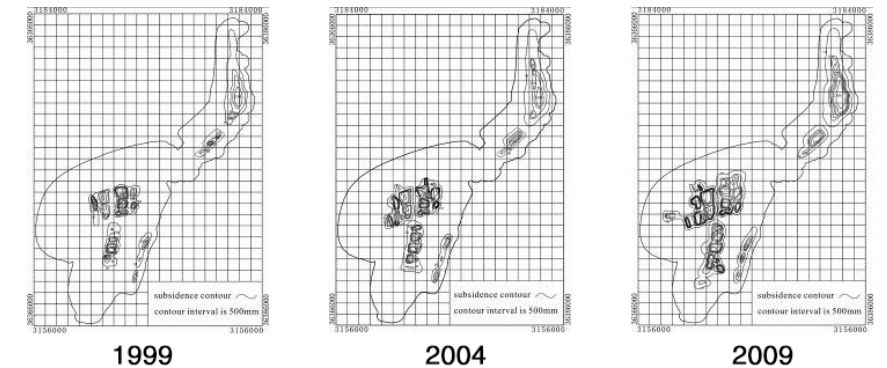
Figure 2. The subsidence contour of Songzao coal mining area.